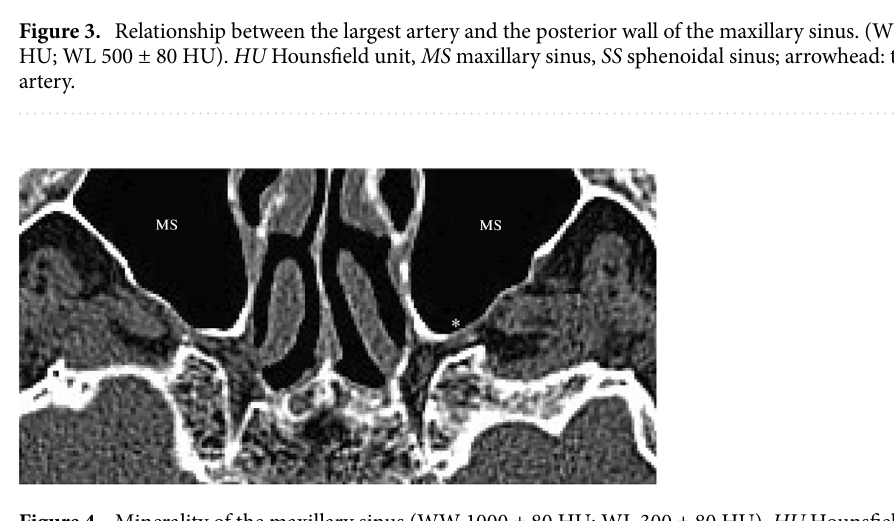
Figure 4. Minerality of the maxillary sinus (WW 1000 ± 80 HU; WL 300 ± 80 HU). HU Hounsfield unit, MS maxillary sinus, *decrease in bone density on the left posterior wall of the maxillary